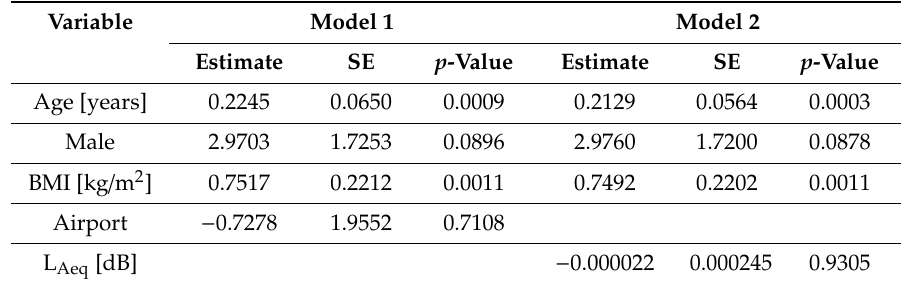
Table 7. Linear mixed e ff ect regression models for aircraft noise e ff ects on diastolic blood pressure. Variable Model 1